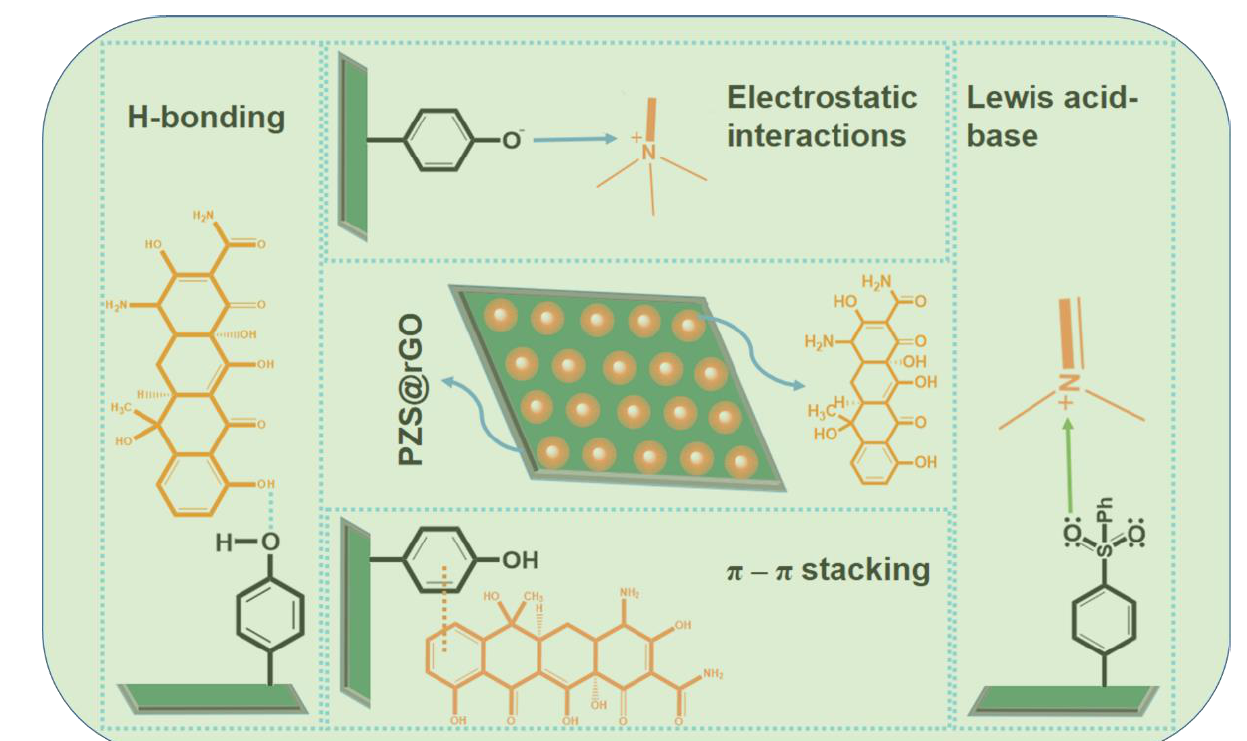
Figure 11. Proposed mechanism of TC decontamination through PZS@rGO.